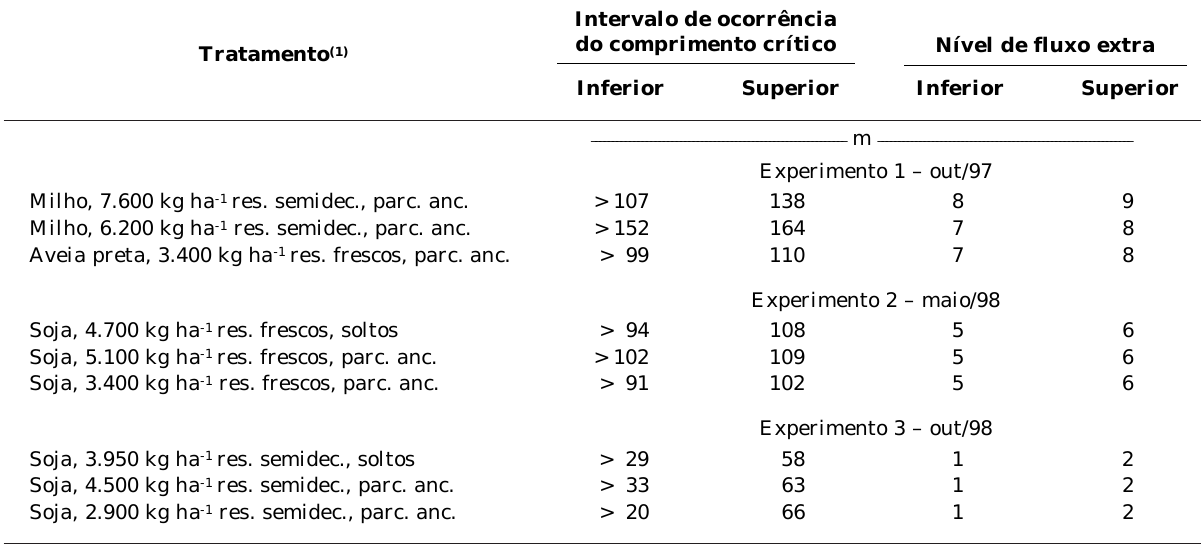
Quadro 2. Intervalos de ocorrência dos comprimentos críticos de rampa determinados para os tratamentos, nos três experimentos, onde foi constatada falha do resíduo